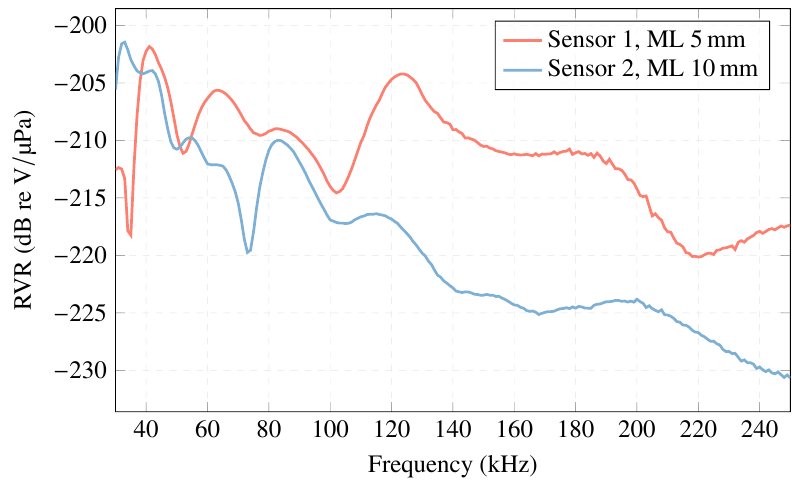
Figure 16. RVR curve for sensors with ML compared to sensors free in the water.